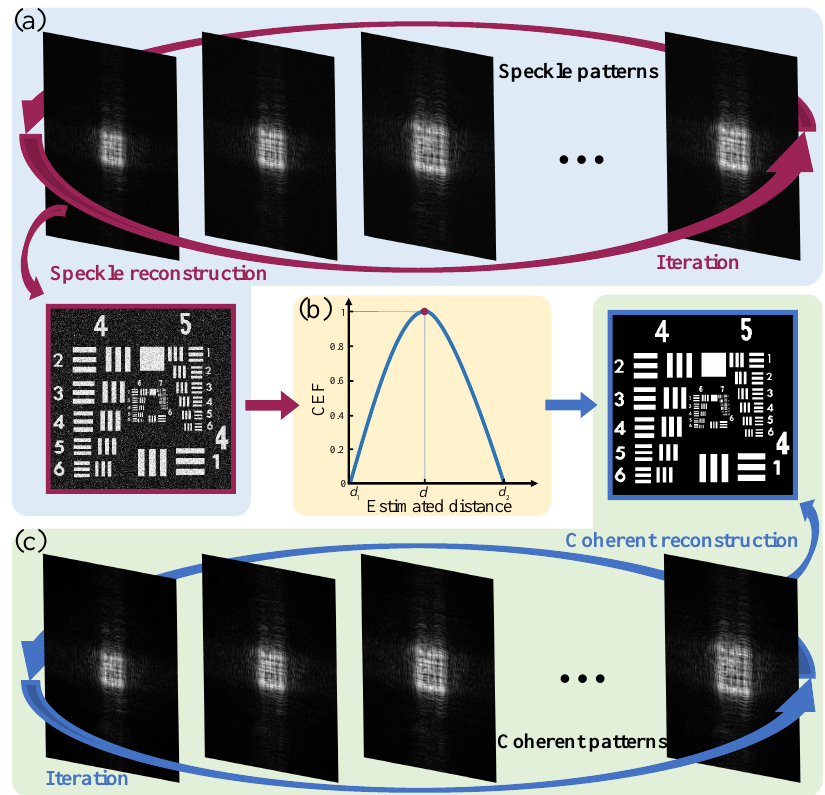
Figure 2. The flowchart of autofocus and image reconstruction in single-lens